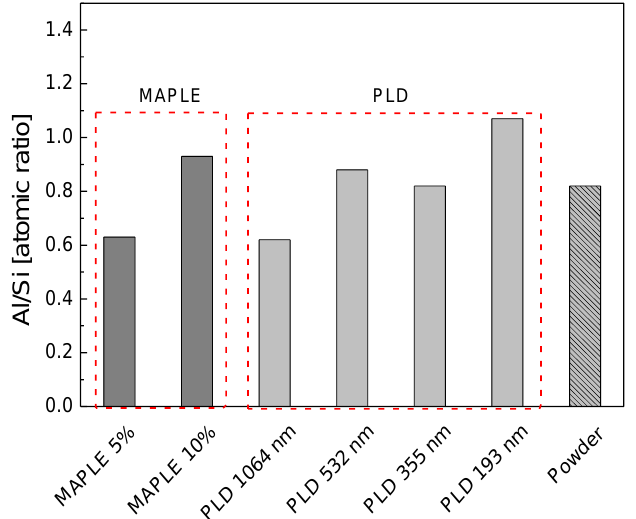
Figure 8. Al/Si atomic ratio for films deposited by MAPLE and PLD, as resulted from XPS survey. In Figure 9a are shown water contact angle measurements (WCA) for kaolinite films obtained by PLD and MAPLE.